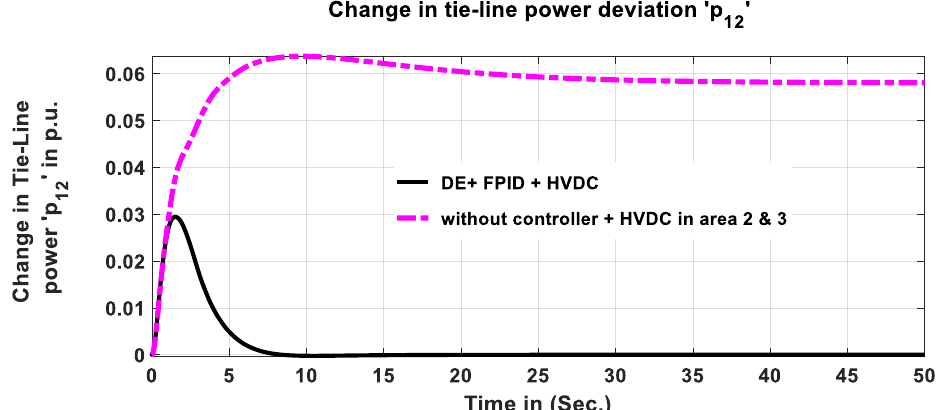
Figure 11. Comparison of controller and without controller + HVDC for change in tie-line power deviation P13.